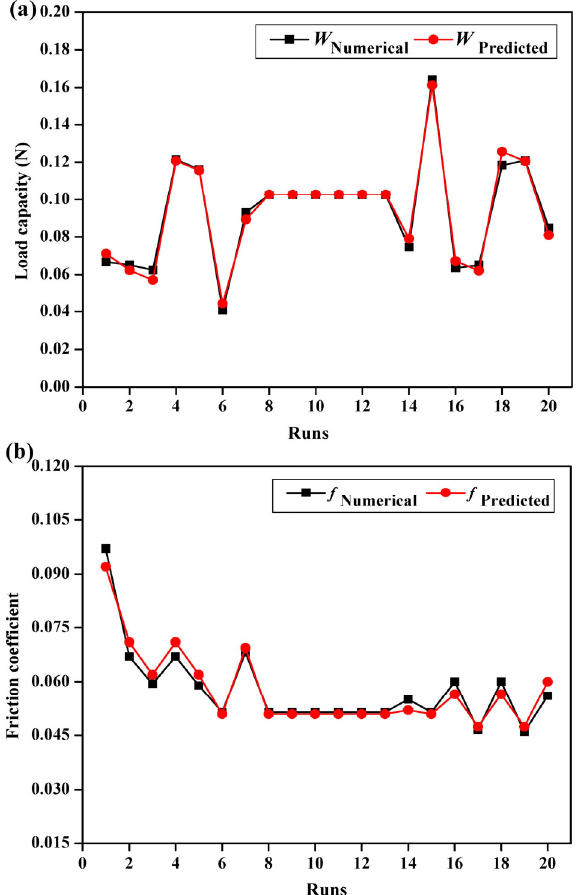
Fig. 18 Numerical and regression model results for (a) load capacity and (b) friction coefficient. Table 13 Numerical and predicted regression model results. Predicted Optimized process Numerical regression parameter result model